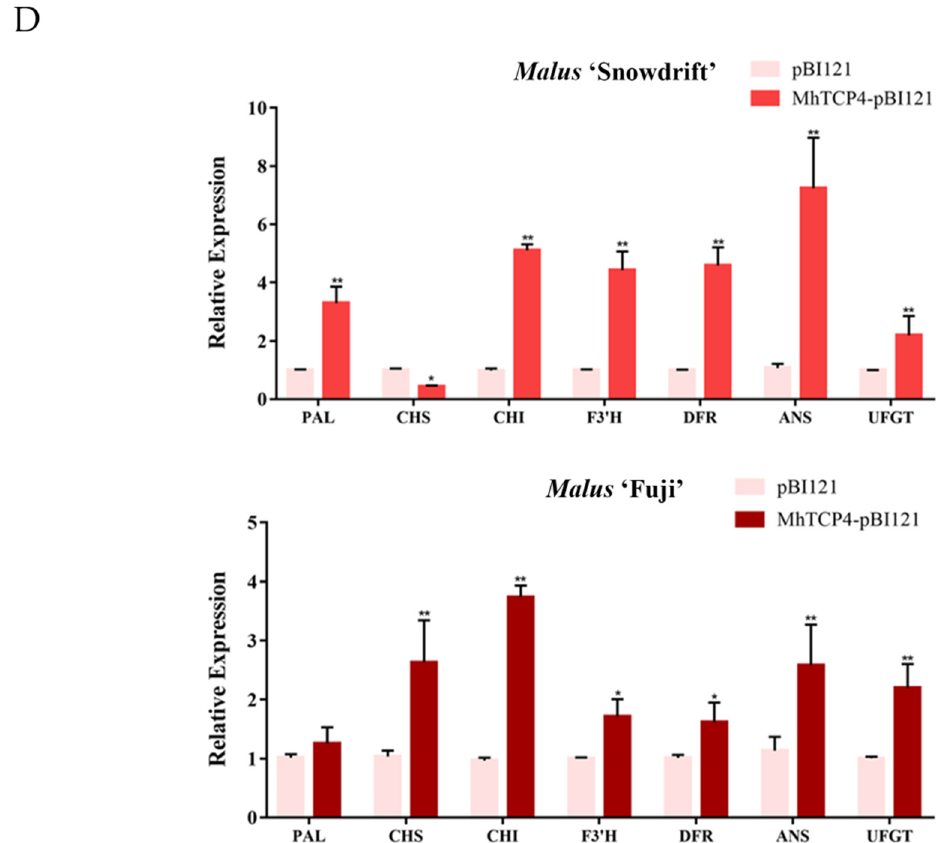
Figure 5. Transient overexpression of MhTCP4 in fruit peels of Malus ‘Snowdrift’ and Malus ‘Fuji’. ( A ) Fruit peel coloration around injection sites. MhTCP4-pBI121 were used for overexpression with the pBI121 vector. Empty vectors were the control. ( B ) The cyanidin 3-galactoside content of transgenic and control fruit peels. ( C ) The expression levels of MhTCP4 in MhTCP4 -overexpression and control fruit peels. ( D ) The expression levels of anthocyanins biosynthesis genes in MhTCP4 - overexpression and control fruit peels. Error bars represent the SEs of three biological replicates and three technical replicates. * p < 0.05, ** p < 0.01 using the t -test.